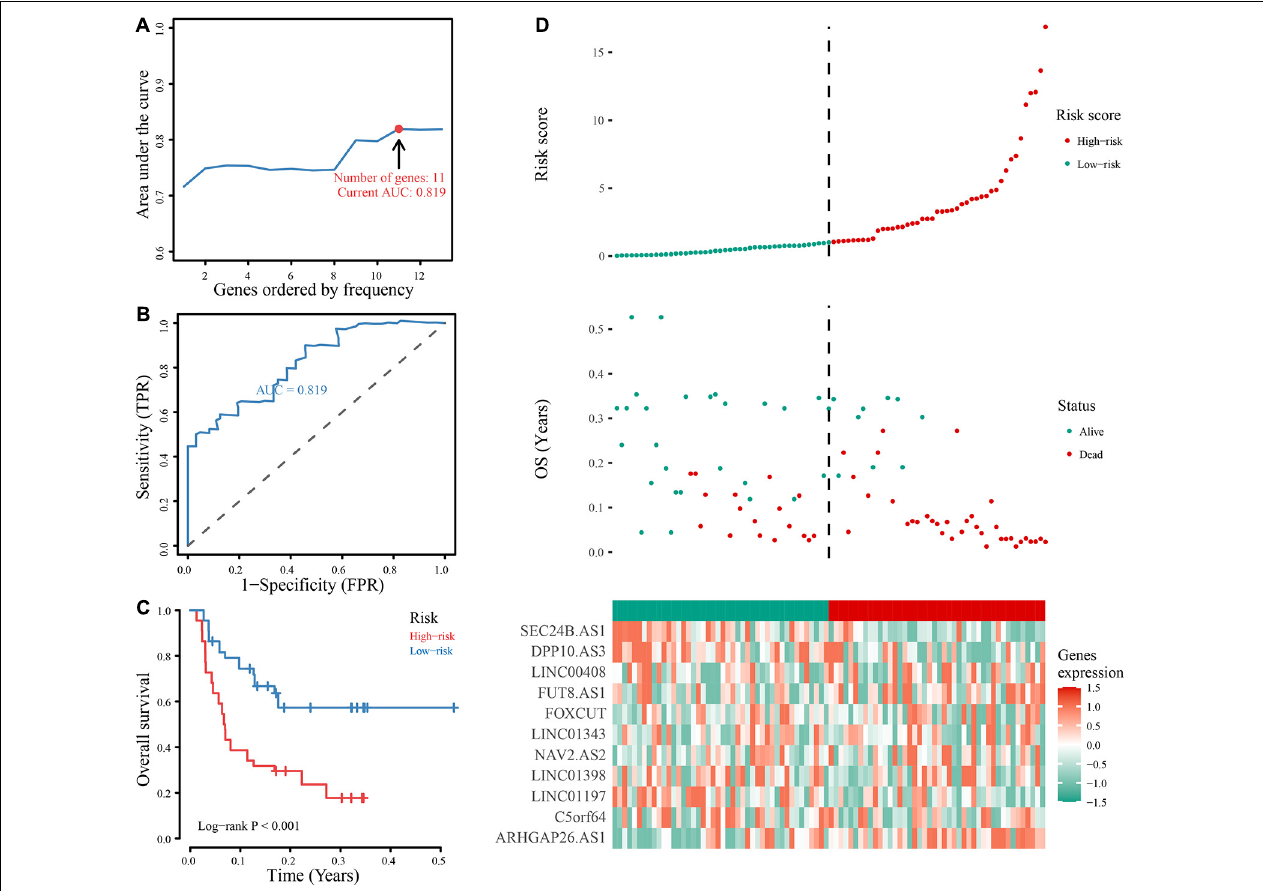
FIGURE 4 | Construction and evaluation of the optimal immune-related lncRNA signature. (A) Line chart of the AUC of different immune-related lncRNA signature models. (B) ROC curve of the immune-related 11-lncRNA signature. (C) Kaplan-Meier analysis of the signature. Survival was compared using the log-rank test. (D) Evaluation of the 11-lncRNA signature based on risk factors in the high- and low-risk groups, the RFS, and gene expression in the signature.